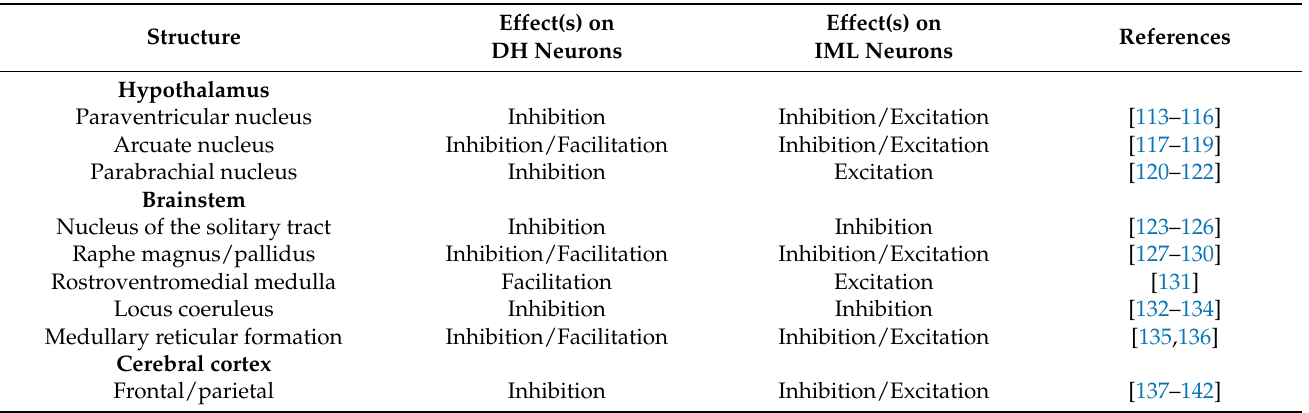
Table 2. Overview of monosynaptic pathways descending to the spinal cord that influence both second-order sensory neurons and sympathetic preganglionic